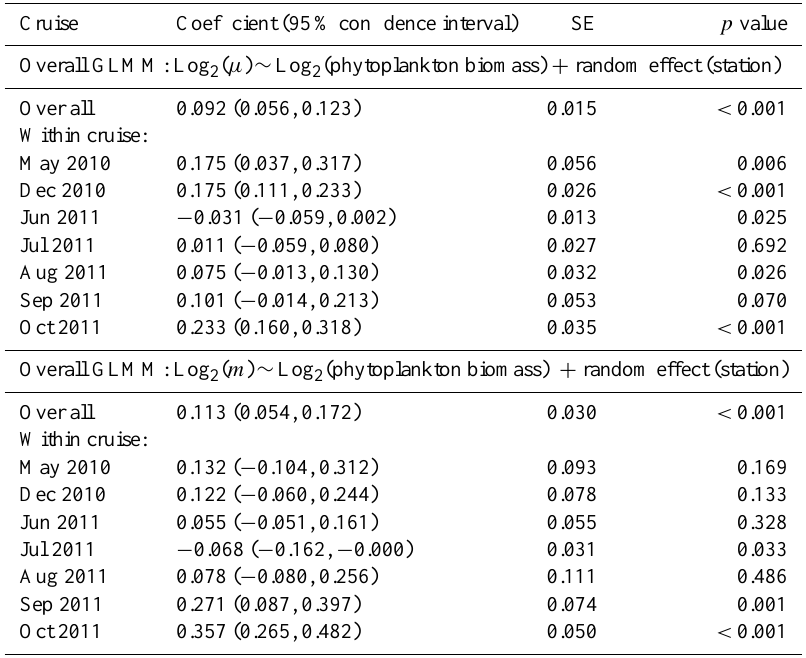
Table 1. Results of the generalized linear mixed effect model (GLMM) linking microphytoplankton size-specific growth rate ( µ ) and grazing mortality ( m) with microphytoplankton body size (biomass). In GLMM, stations were considered as the random